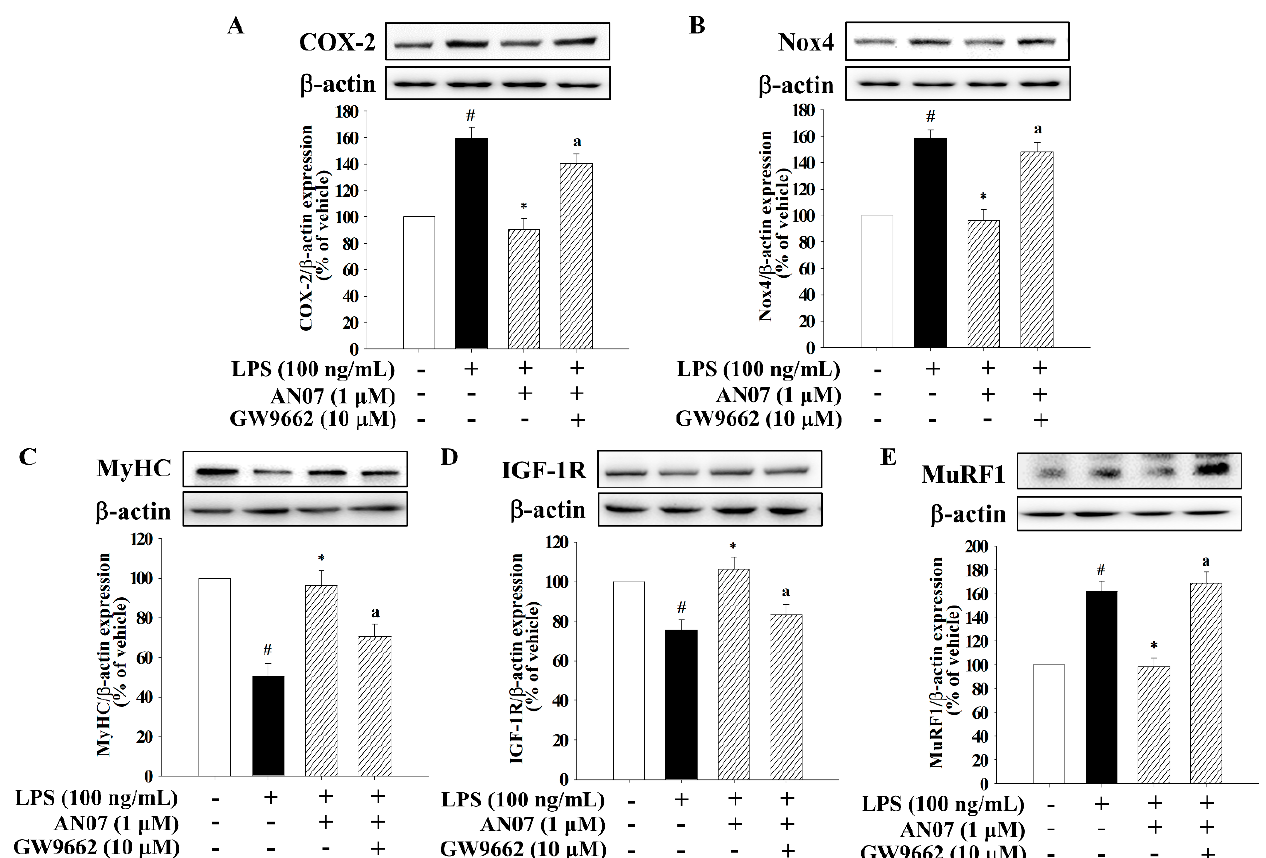
Figure 8. GW9662 (PPAR γ antagonist) attenuated the anti-inflammatory, antioxidant, and antiatrophic effects of AN07 in LPS-treated C2C12 myotubes. Myotubes were treated with or without GW9662 (10 μ M) 1 h before AN07 (1 μ M) treatment for 1 h and then treated with LPS (100 ng/mL) for ( A ) 2 h or ( B – E ) 24 h. The protein expressions of ( A ) COX-2, ( B ) Nox4, ( C ) MyHC, ( D ) IGF-1R,